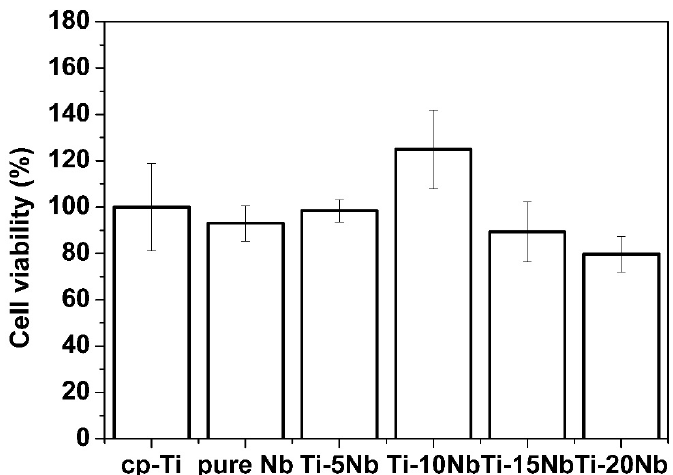
Figure 9. Percent cell viability of pure metals and their Ti based alloys versus cp-Ti after cell culture for 24 h ( n = 7).